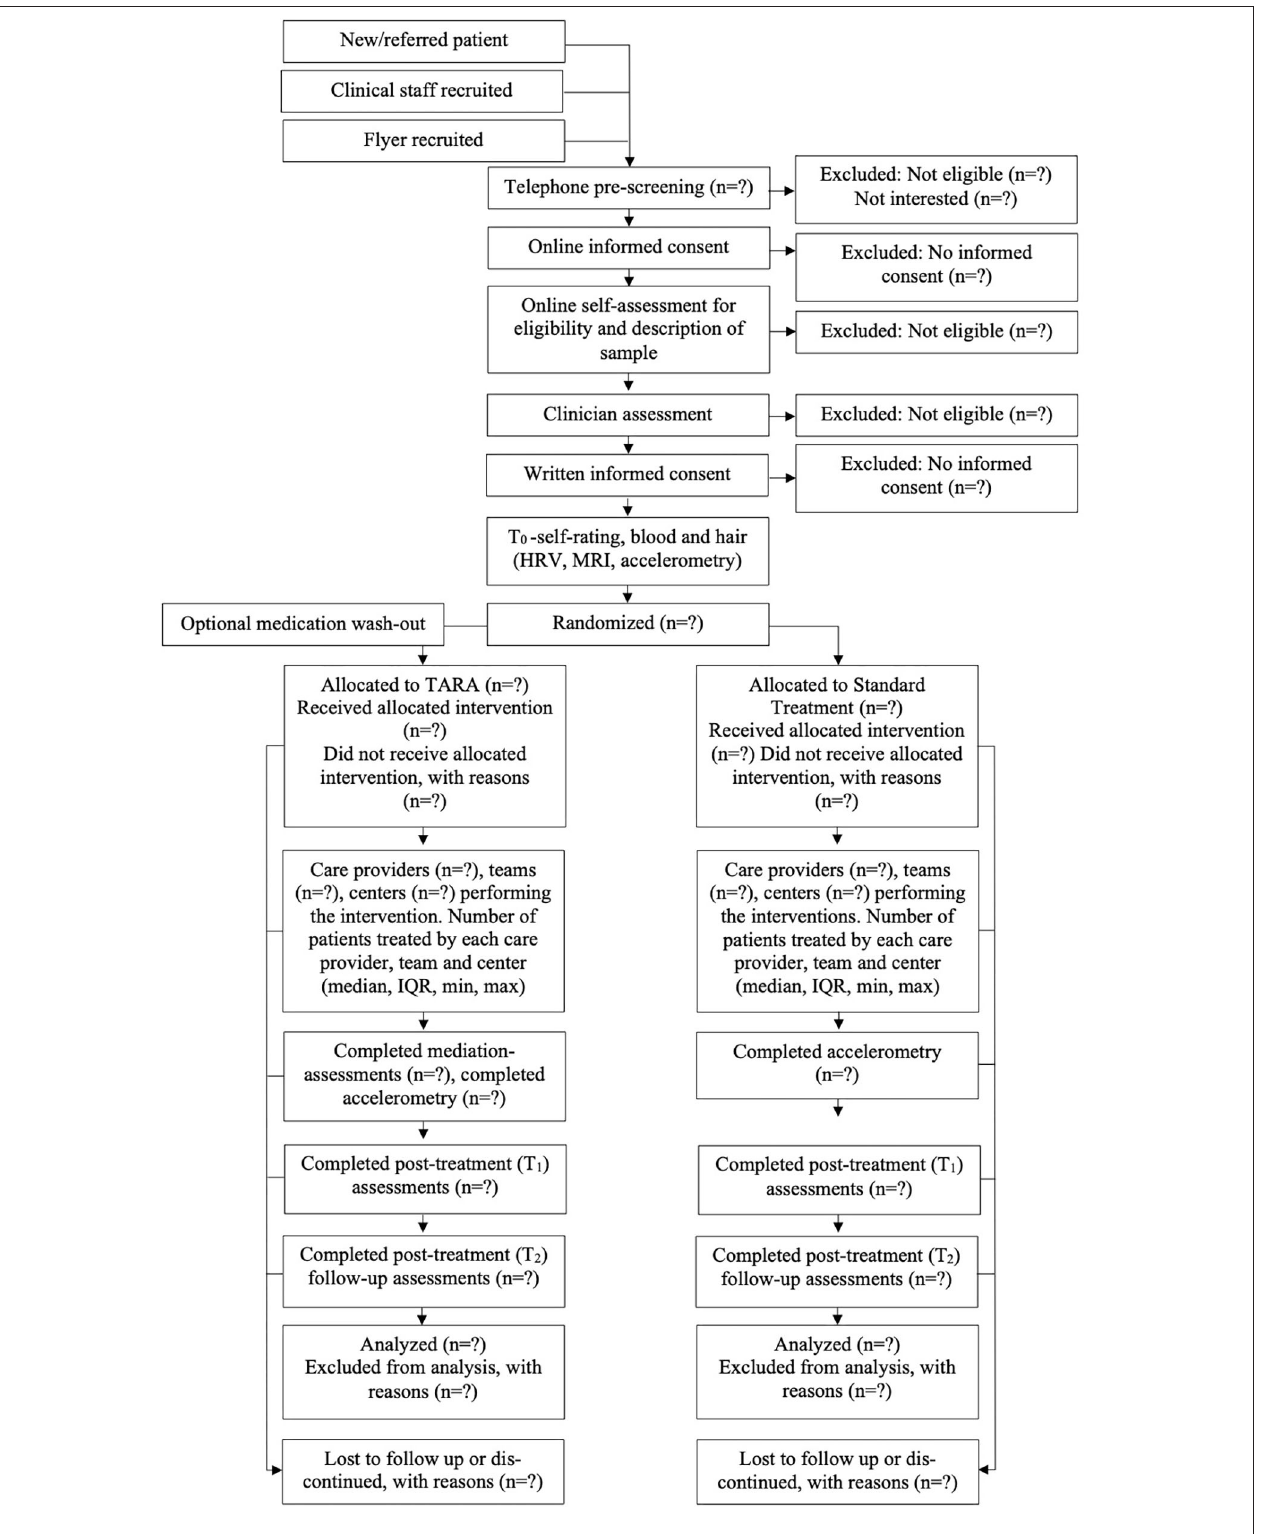
FIGURE 1 | Flow of